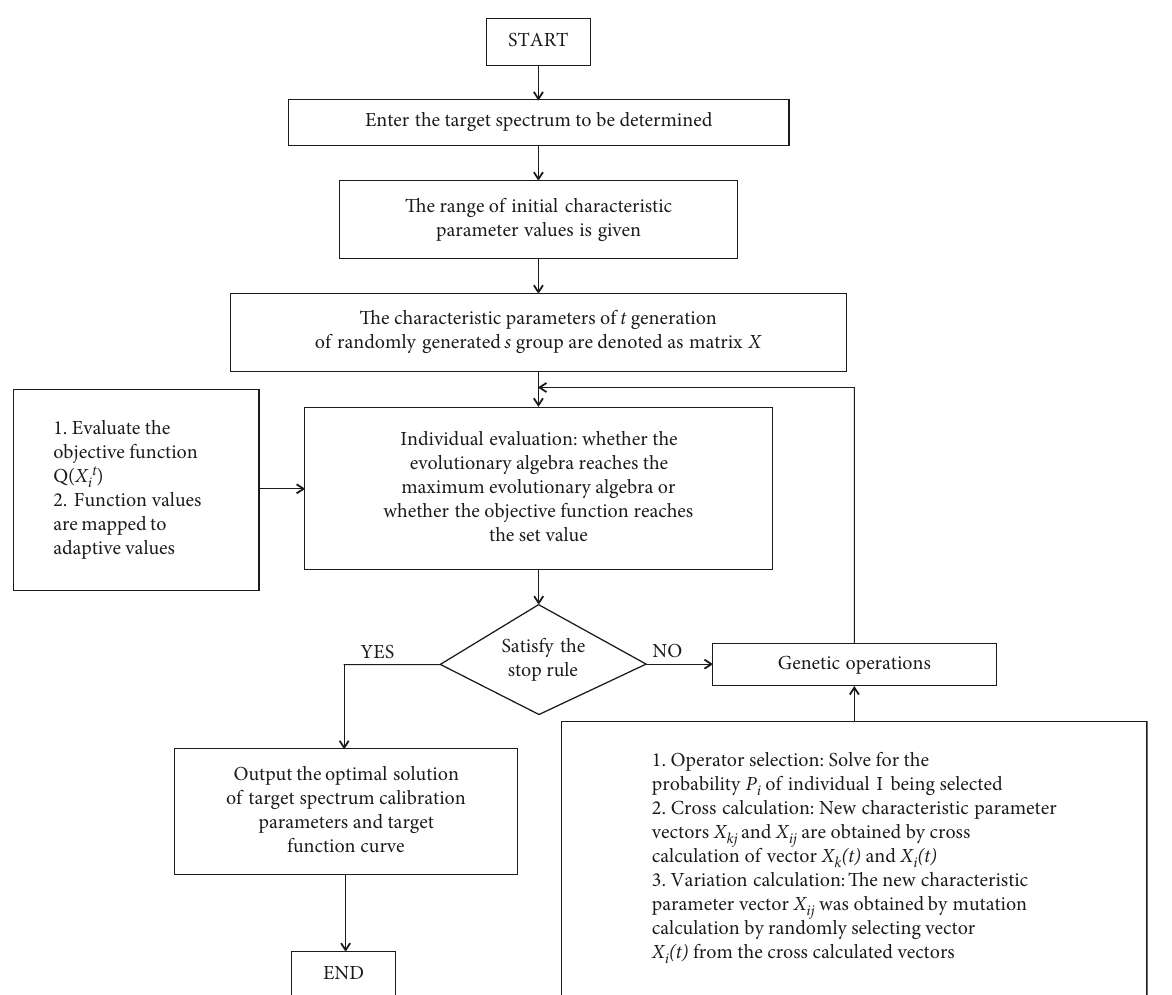
Figure 2: Flow chart of genetic algorithm calibration target spectrum and characteristic